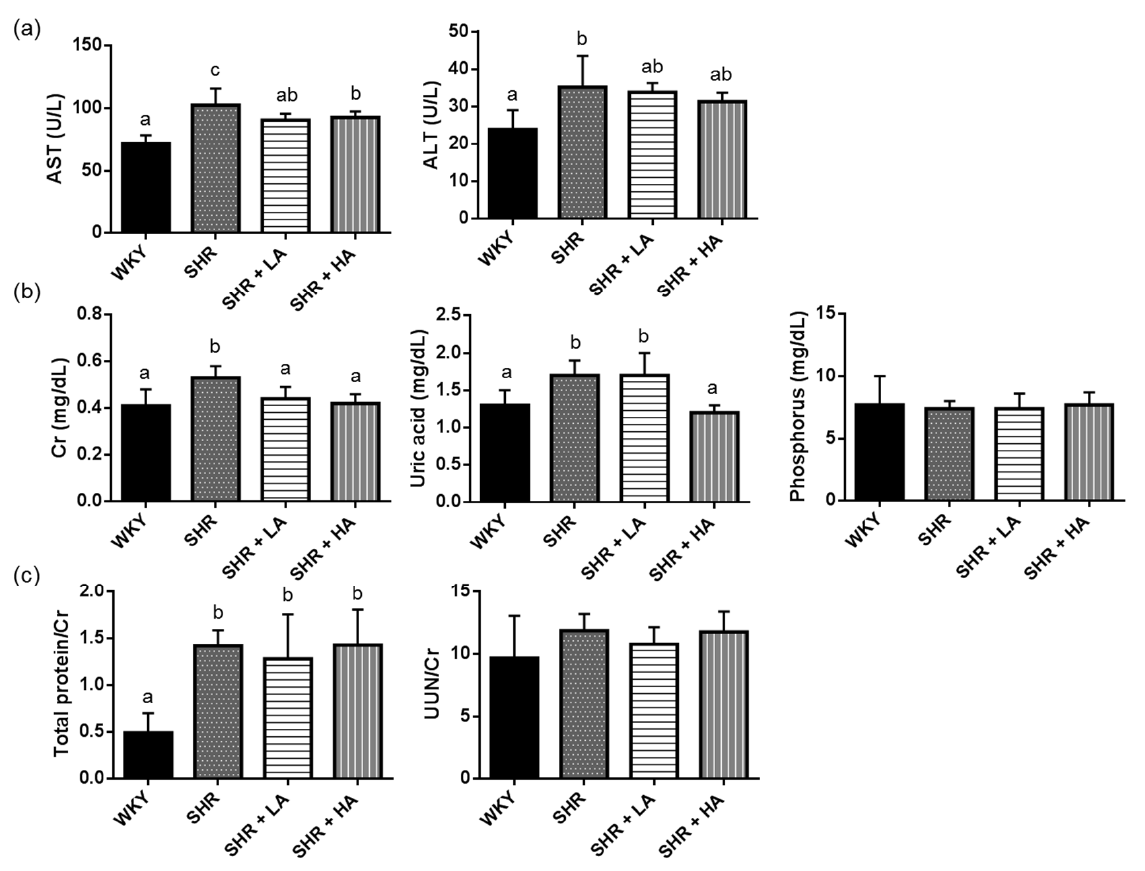
Figure 3. Plasma hepatic ( a ), renal function parameters ( b ), and urine analysis ( c ) of rats in different groups. Values are presented as mean ± SD ( n = 10). abc Different superscript letters indicate a significant difference ( p < 0.05). AST, aspartate aminotransferase; ALT, alanine aminotransferase; UUN, urine urea nitrogen. WKYWistar Kyoto rats fed an AIN-93M diet; SHR, spontaneously hypertensive rats fed an AIN-93M diet; SHR + LA, SHRs fed an AIN-93M diet containing 12% dehulled adlay powder; SHR + HA, SHRs fed an AIN-93M diet containing 24% dehulled adlay powder.